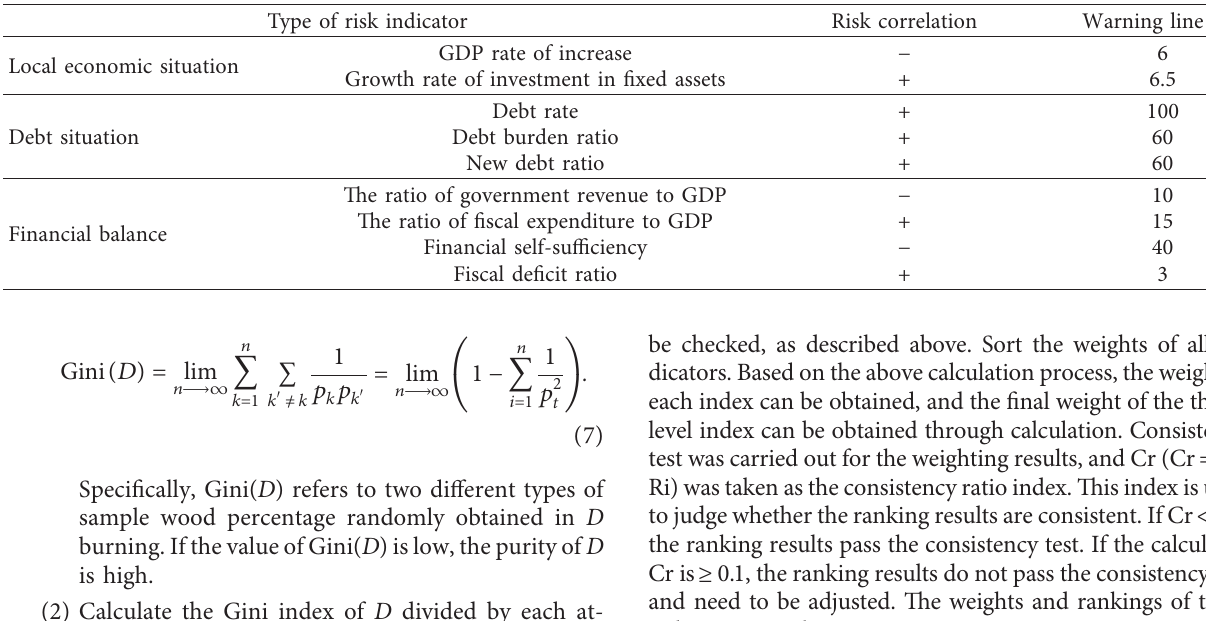
Table 1: Government debt risk index system